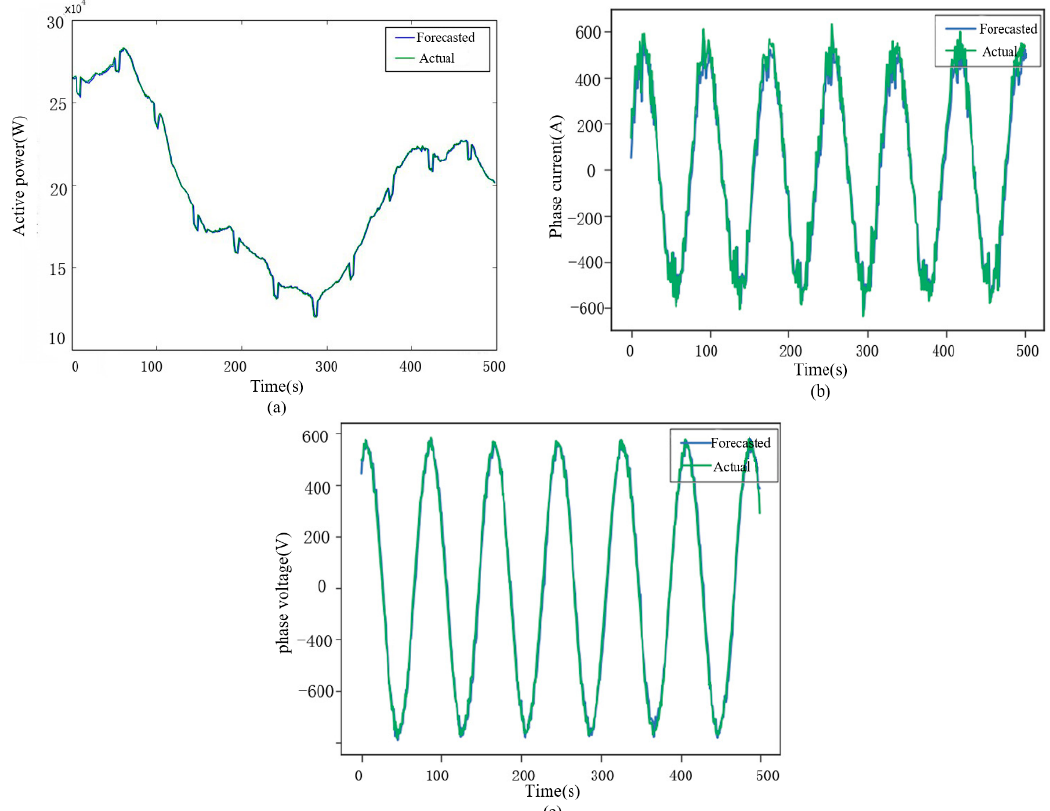
Figure 9. Comparison of actual output and predicted output. ( a ) Active power; ( b ) Phase current; ( c ) Phase voltage.